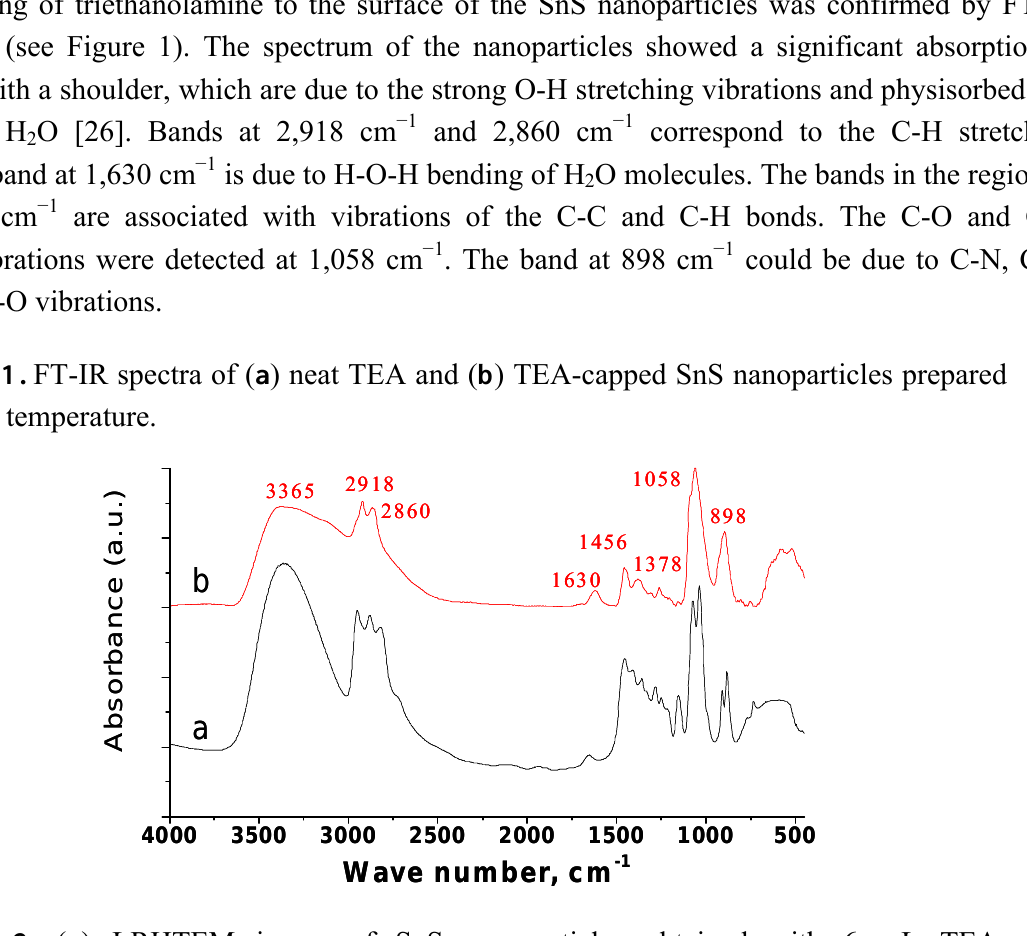
Figure 2. ( a ) LRHTEM image of SnS nanoparticles obtained with 6 mL TEA; ( b ) Histogram of size distribution of SnS nanoparticles made with 6 mL